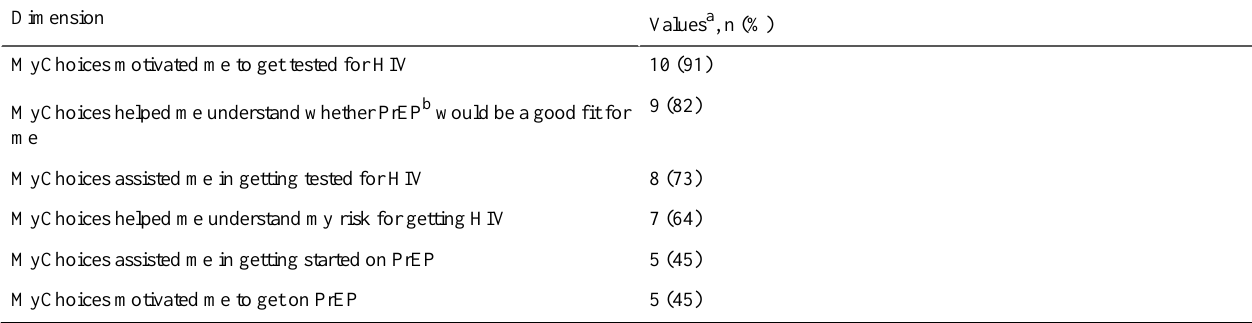
Table 3. Utility of the MyChoices app for HIV prevention in young men who have sex with men in Boston, Massachusetts, and the Bronx, New York City, 2019